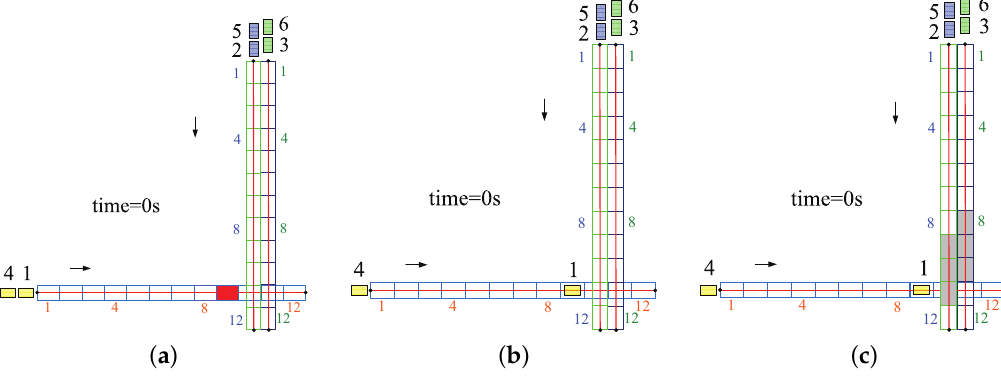
Figure 14. Step 1, ( a ) find the optimal VG, ( b ) assign the first waiting CAV, ( c ) mark the CVGs.